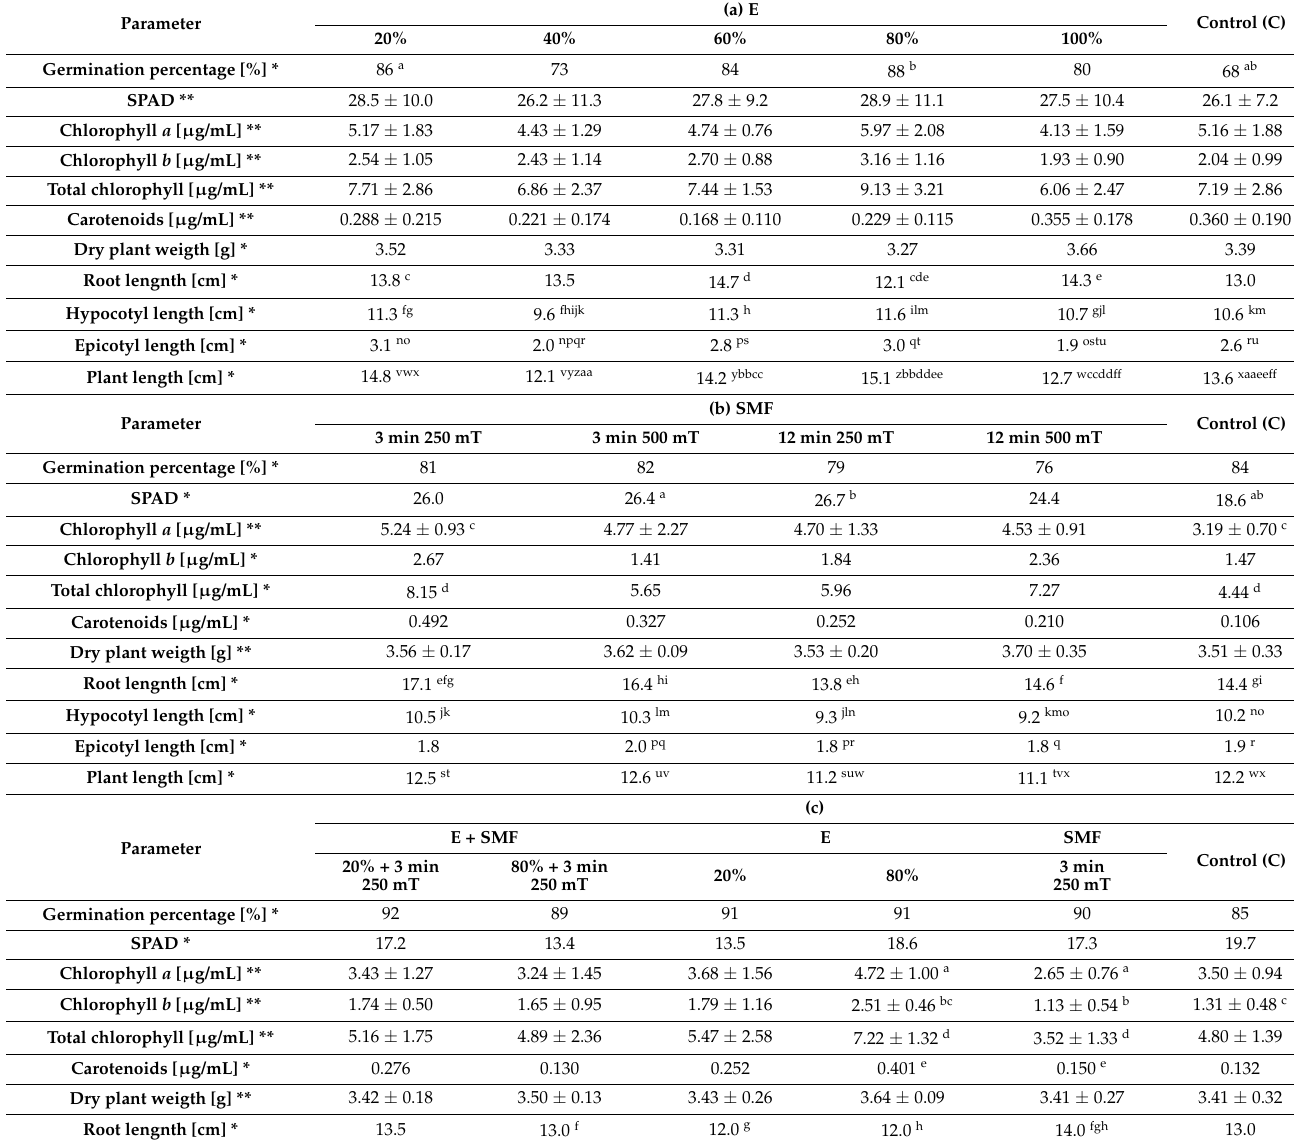
Table 3. Germination percentage, plant growth parameters and the content of chlorophyll and carotenoids in leaves for treatment of soybean with (a) Cladophora glomerata extract (E), (b) static magnetic field (SMF), and (c) combination of both factors (E +